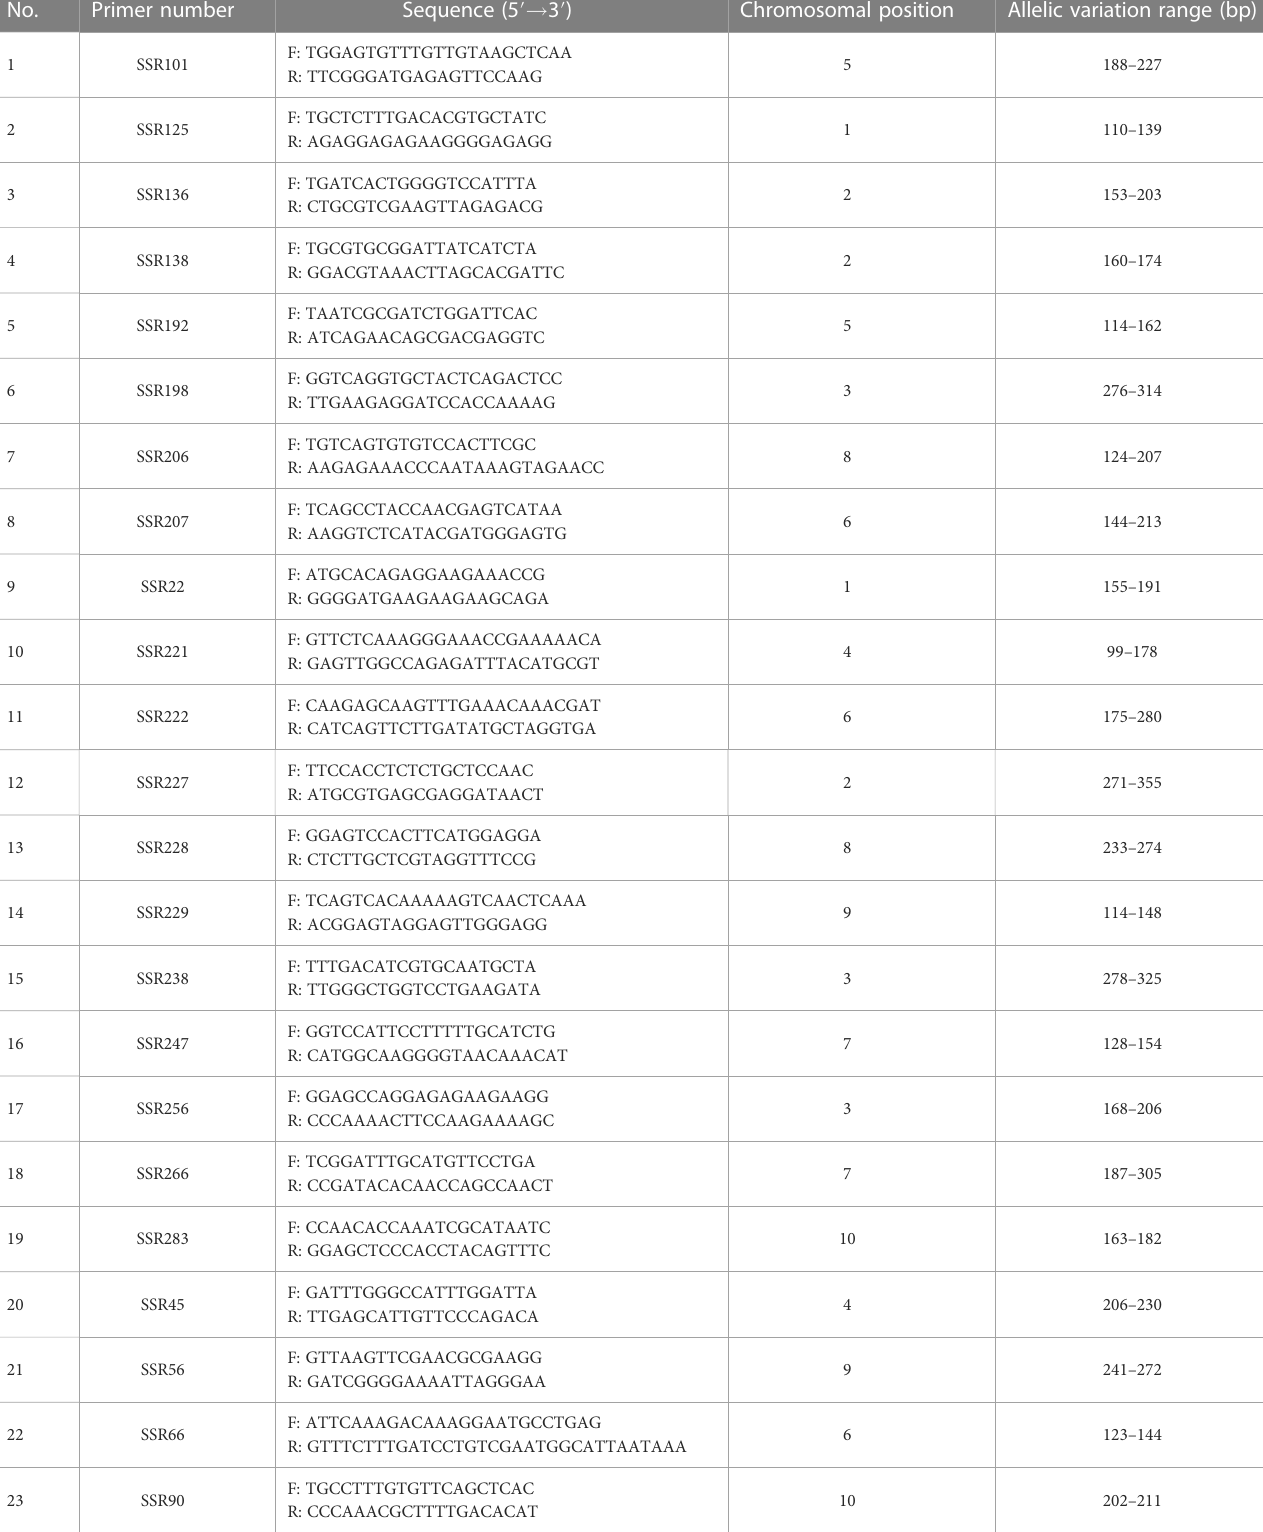
TABLE 2 Chromosome distribution and allelic variation range of the 23 primer sequences studied.